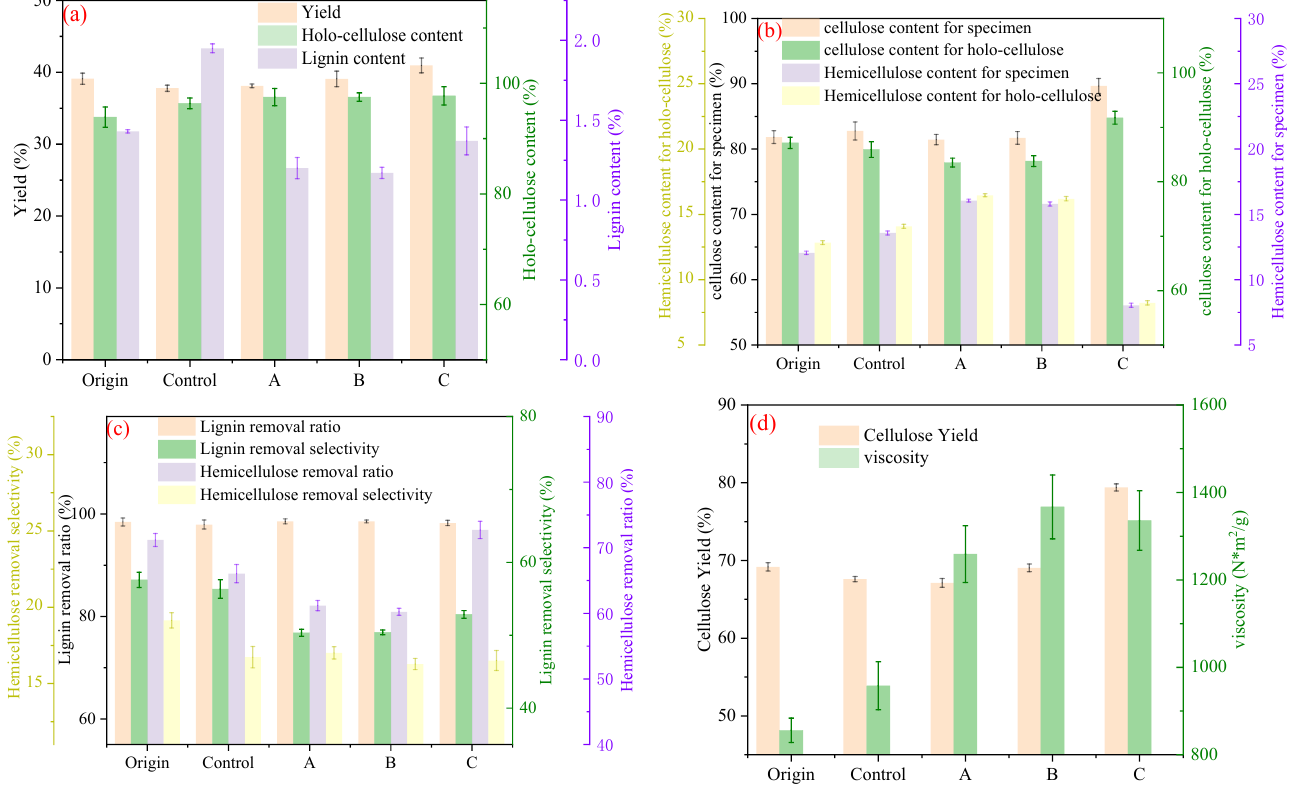
Figure 5. ( a ) Yield, holocellulose, and lignin content; ( b ) α -cellulose and hemicellulose content; ( c ) removal ratio and removal selectivity of lignin and hemicellulose; ( d ) cellulose yield and viscosity of specimens via Kraft cooking. A: pulp obtained from bamboo chips pretreated by microorganisms A, B: pulp obtained from bamboo chips pretreated by microorganisms B, C: pulp obtained from bamboo chips pretreated by microbial consortium C.